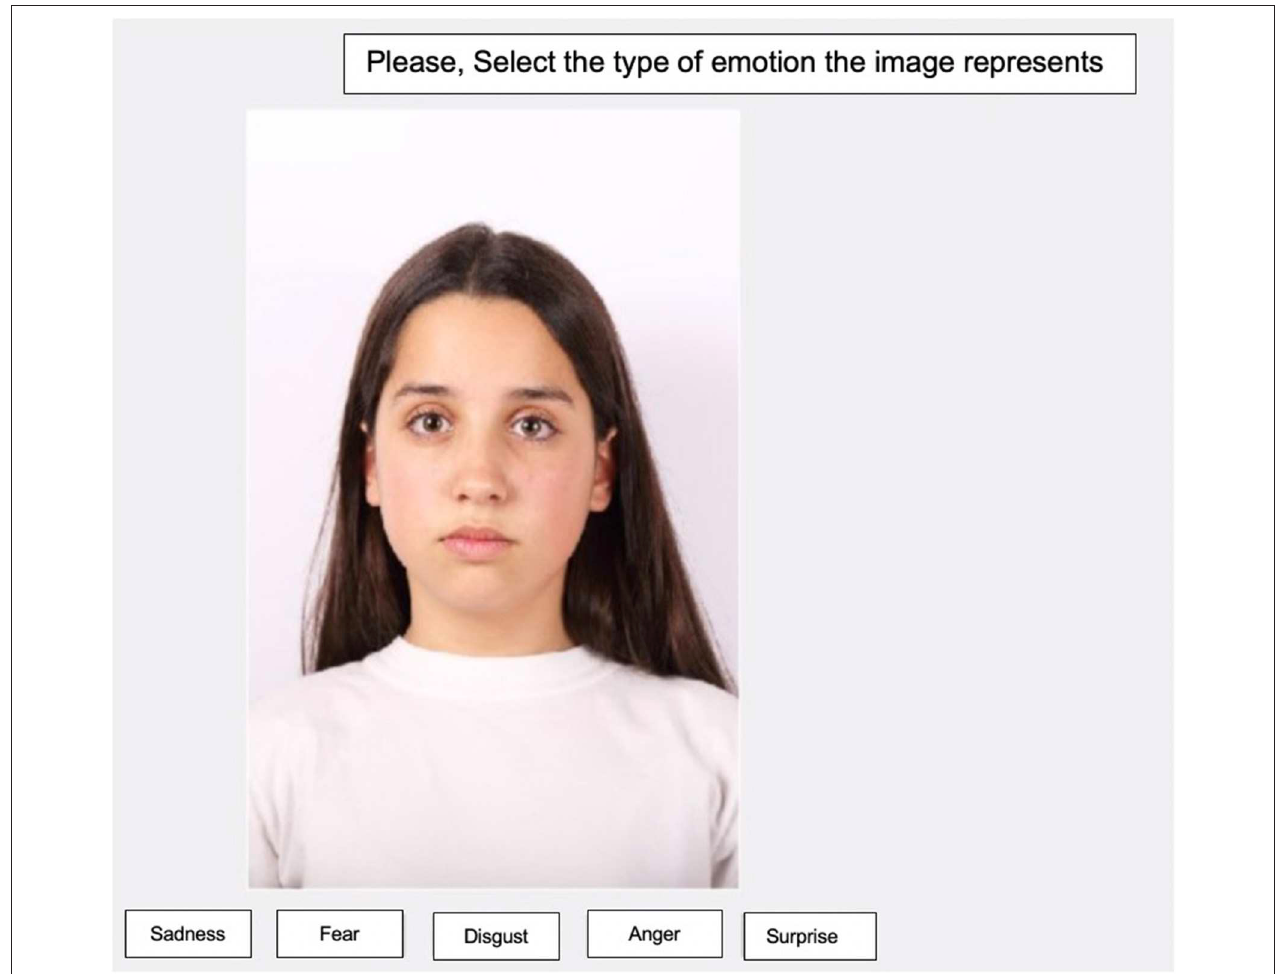
FIGURE 3 | Reactive female model facial expressions of fear low